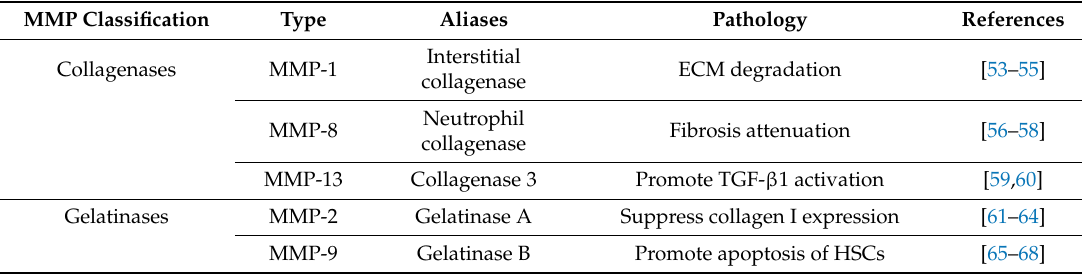
Table 4. Summary of matrix metalloproteinases